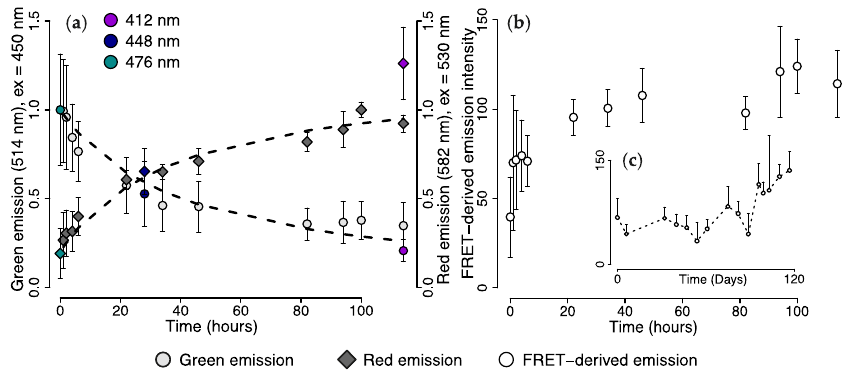
Figure 5. In vivo photoconversion of green M. cavernosa under 412 nm light. The colony had been previously kept under 476 nm light for >123 days. ( a ) Green (514 nm) emission measured over 110 h with 450 nm excitation light; red (582 nm) emission measured with 530 nm excitation light. Dashed lines show fitted second order reaction rate models; model equations and results of statistical analysis are provided in Table S2. Coloured data points show values after long-term exposure to 412, 448 and 476 nm light; ( b , c ) FRET-derived emission intensity (582 nm) measured with 450 nm excitation light and corrected according to Equations (2)–(4). Values calculated for short-term exposure to 412 nm LED after acclimation with 476 nm LED, means ± S.D., n = 5 ( b ); and for long-term exposure to 412 nm LED after acclimation with white metal halide, means + S.D., n = 6 ( c ).